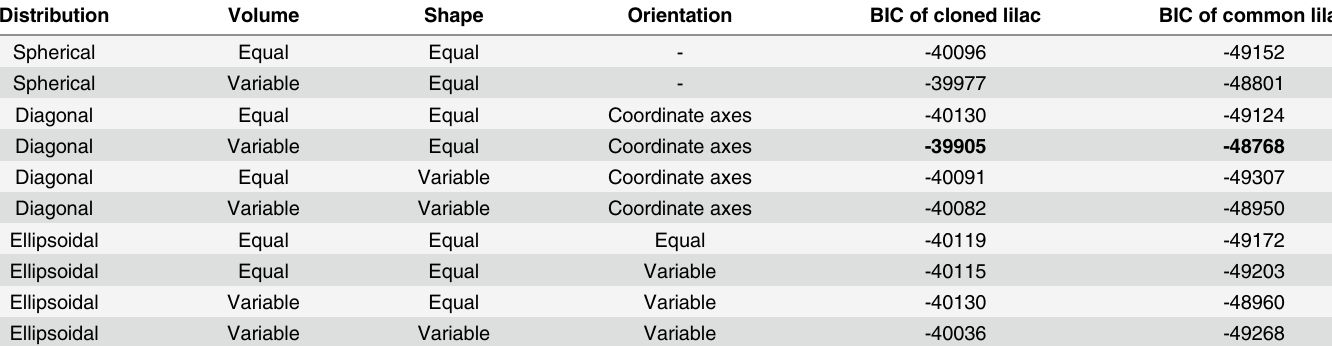
Table 2. The fitted mixture models currently in the “ mclust ” package and their corresponding BIC values.